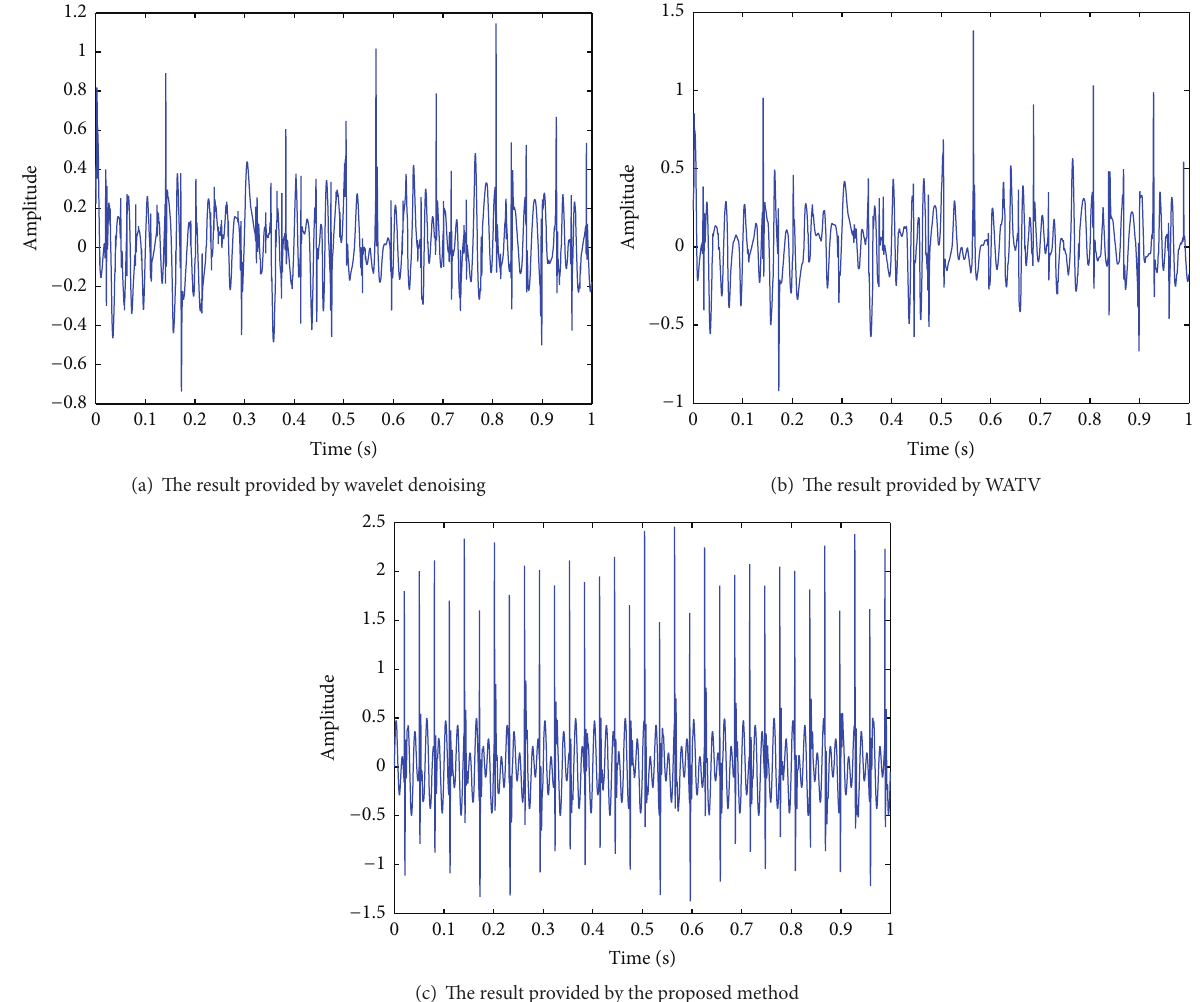
Figure 3: The denoising performance of different